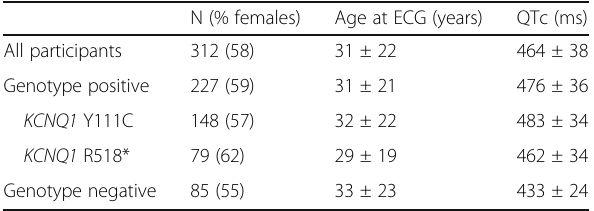
Table 1 Overview of the Swedish LQT1 founder study population